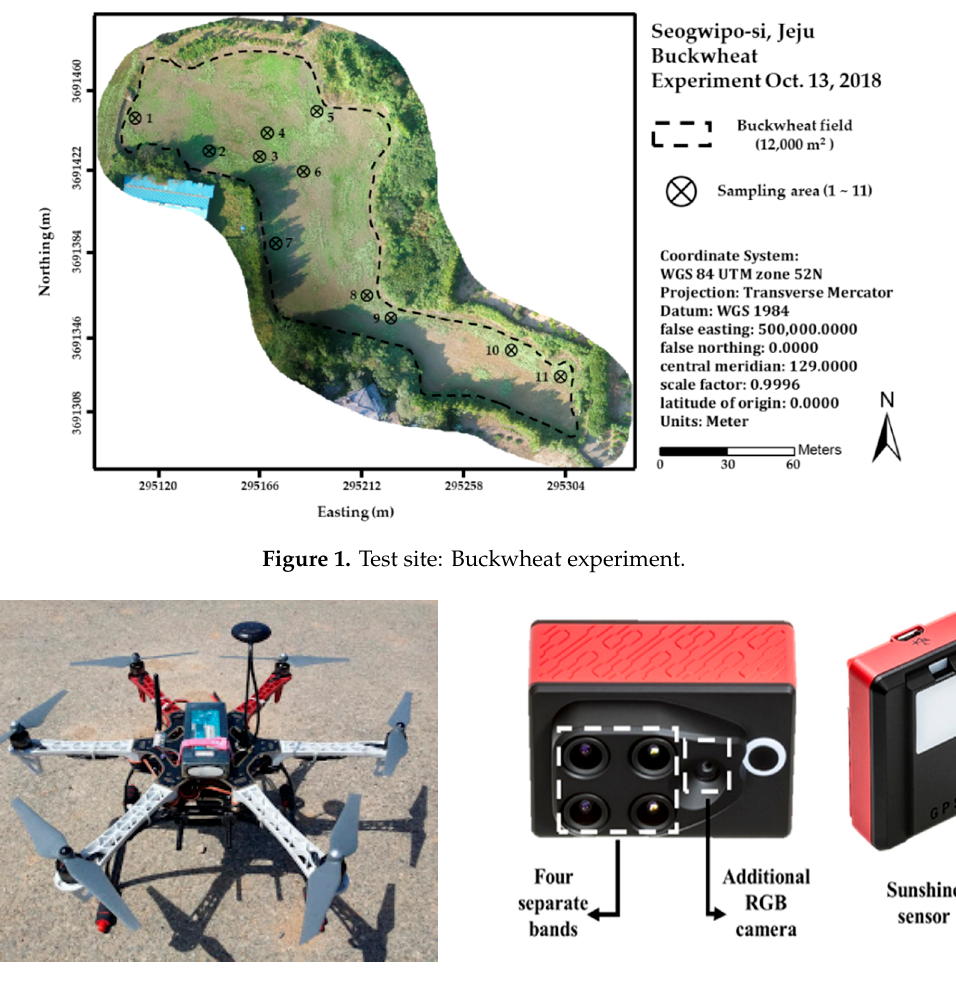
Table 1. Details of UAV flight in this study.